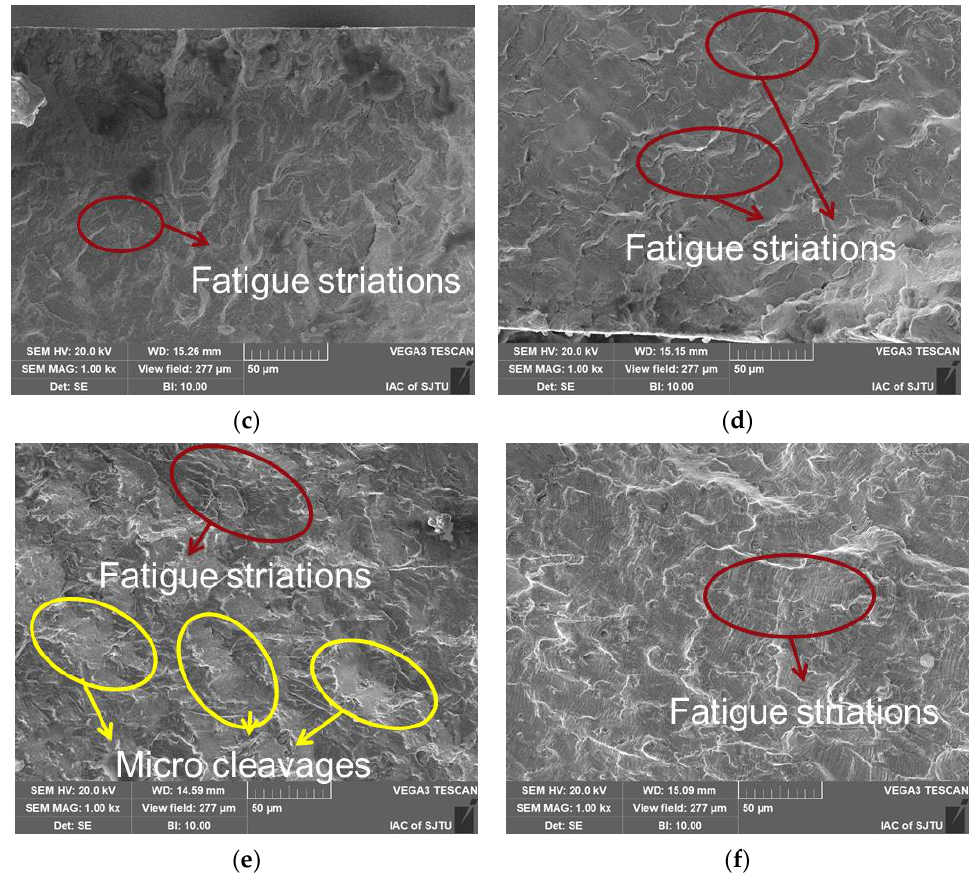
Figure 12. SEM micrographs revealing typical structure in crack initiation zone for specimens with LSP (( a ) 1.2% strain amplitude, ( c ) 0.8% strain amplitude, ( e ) 0.4% strain amplitude) and specimens without LSP (( b ) 1.2% strain amplitude, ( d ) 0.8% strain amplitude, ( f ) 0.4% strain amplitude).